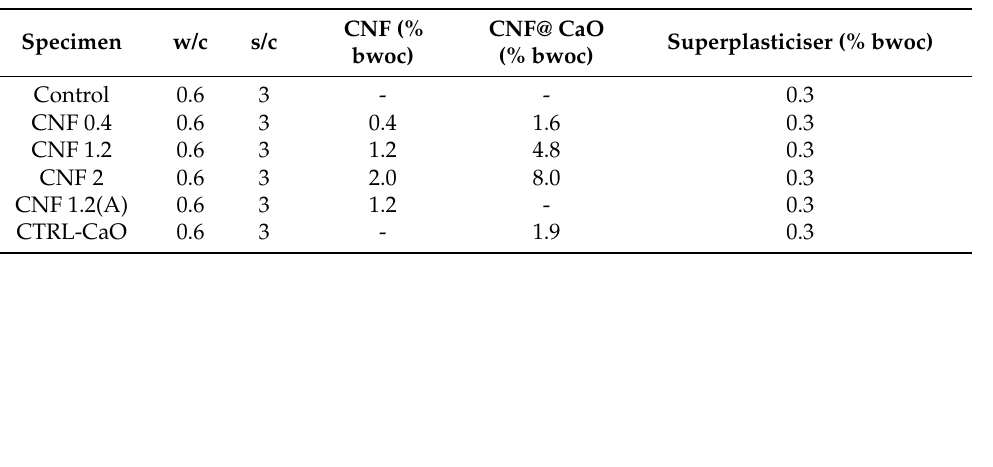
Table 1. Mix proportions used for test